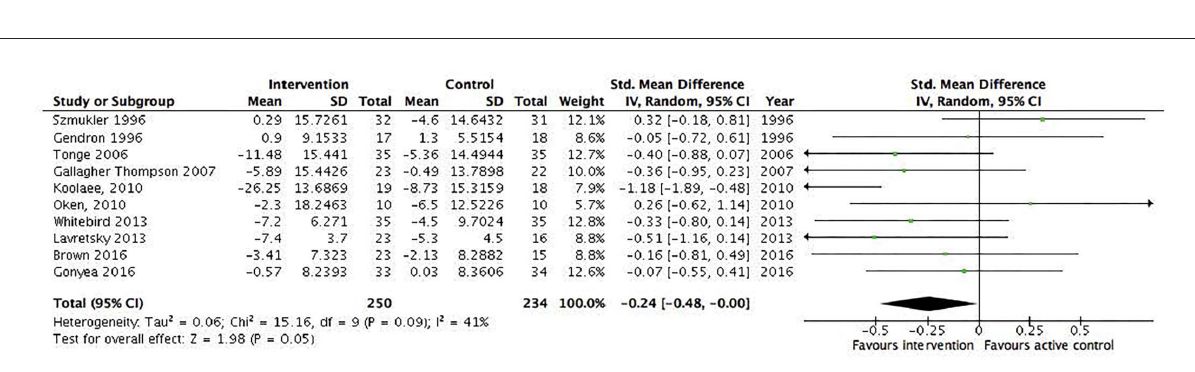
FIGURE3 Subgroup analysis of all informal caregiver interventions that included an active control group. Mean within-group changes and standardized mean